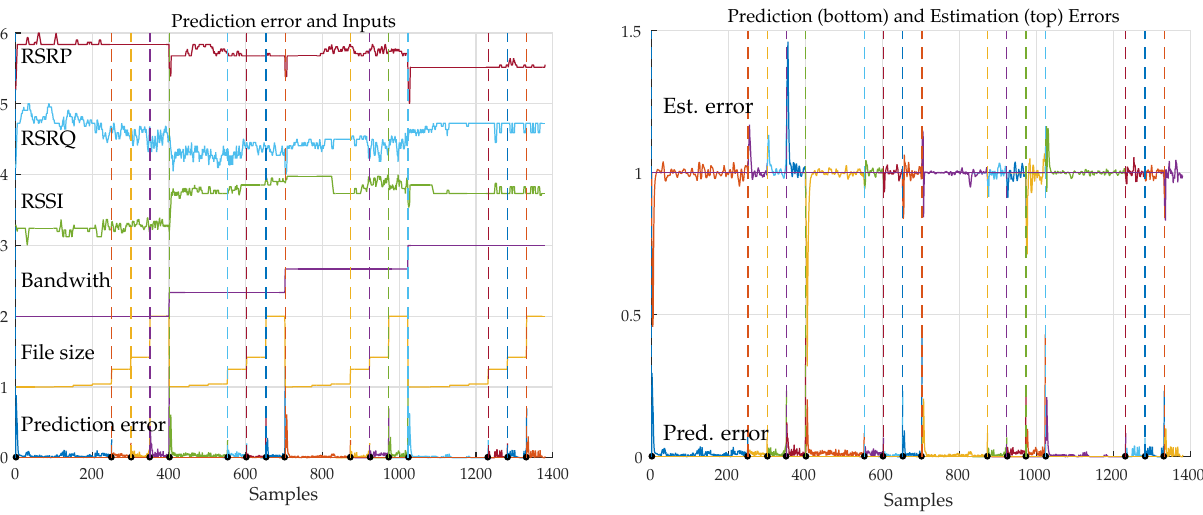
Figure 4. ( left ) input signals and sum of prediction errors (not in scale). ( right ) corresponding prediction and estimation Figure 4. Left: input signals and sum of prediction errors (not in scale). Right: corresponding errors. Dashed lines correspond to events with large prediction prediction and estimation errors. Dashed lines correspond to events with large prediction errors.